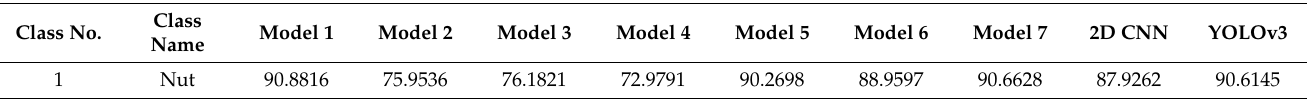
Table 2. Accuracy comparison of different models.